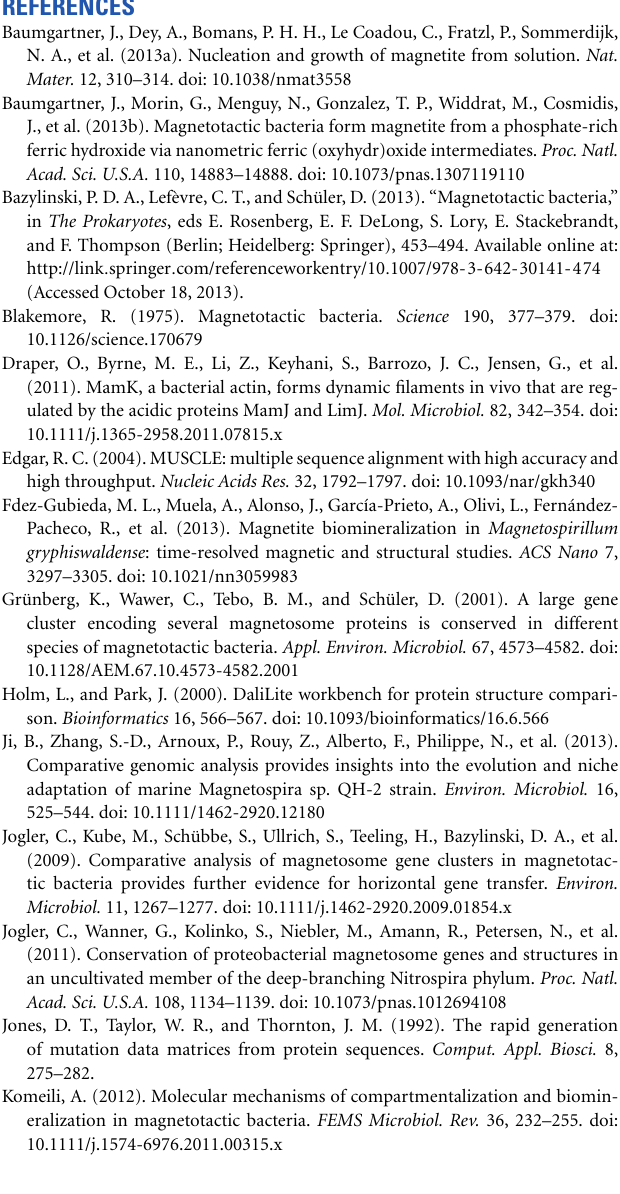
Supplementary Figure 1| Sequence alignment of MCR domains used in this analysis. Sequence alignment is colored as defined by clustalx in Jalview 2 (Waterhouse et al.,